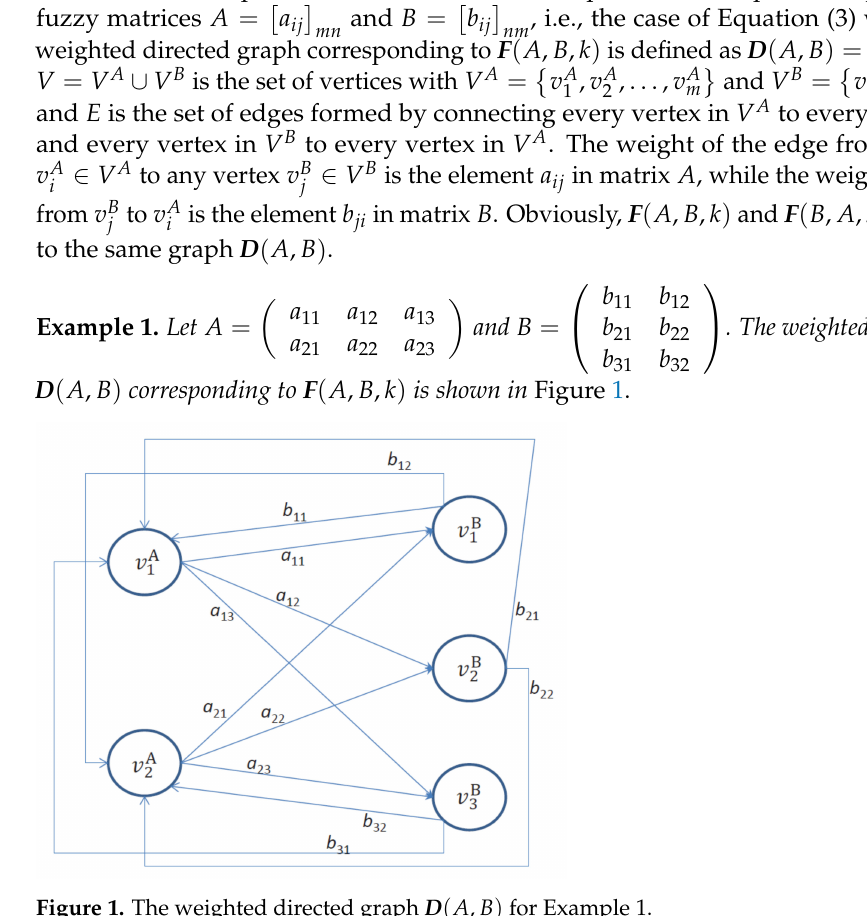
Figure 1. The weighted directed graph D ( A , B ) for Example